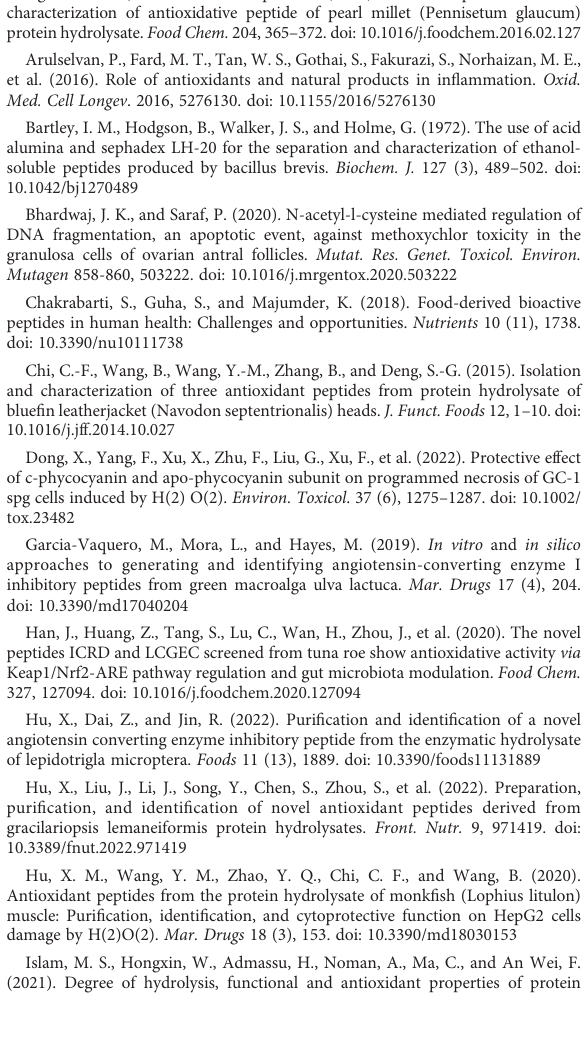
SUPPLEMENTARY FIGURE 1 Response surface plots depicting the effects of reaction temperature, pH of buffer, material-to-liquid ratio and enzyme concentration on antioxidant activity of C-PC hydrolysates prepared (A – F) DH; (G – L) DPPH radical scavenging activity. SUPPLEMENTARY FIGURE 2 In vivo antioxidant activity of three isolated P1, P2 and P3. (n = 10, mean ± standard deviation). (A) Transgenic fl uorescent zebra fi sh treated with MTZ (10 mM) and different concentrations of three peptides. (B) Fluorescent spots number statistic results of all groups. * p < 0.05, ** p < 0.01, *** p < 0.001 compared with the MTZ group. #### p< 0.0001 compared with the control group. Scale bar, 200 m m. SUPPLEMENTARY FIGURE 3 Bioactivities of C-Phycocyanin (C-PC). (A) DPPH radical scavenging activity. (B) ABTS radical scavenging activity. (C) In vivo visualization of zebra fi sh skin fl uorescence treatment with vehicle. (D) FS number statistic results of all groups. * p < 0.05, vs. the MTZ group. #### p < 0.0001 vs. the blank control group. Scale bar, 200 m